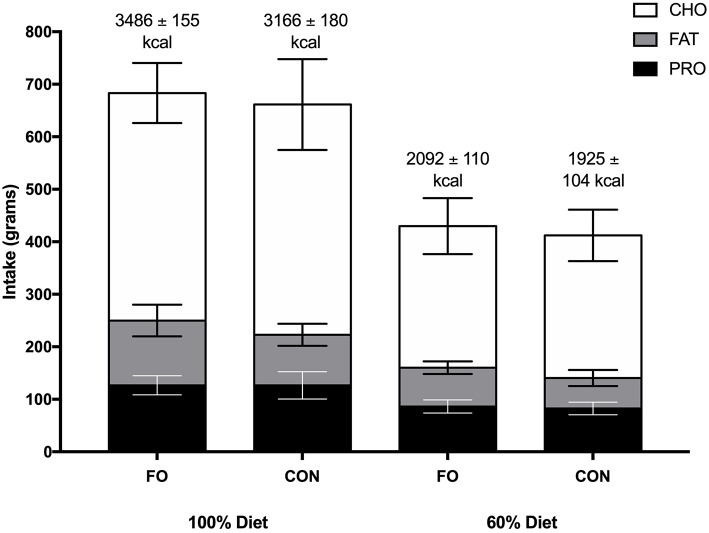
Energy intake (kcal) and macronutrient composition (grams) during the 100% diet period and the 60% diet period in fish oil (FO) and control (CON) supplement groups. Values are means ± SD. CHO, carbohydrate; PRO, protein.